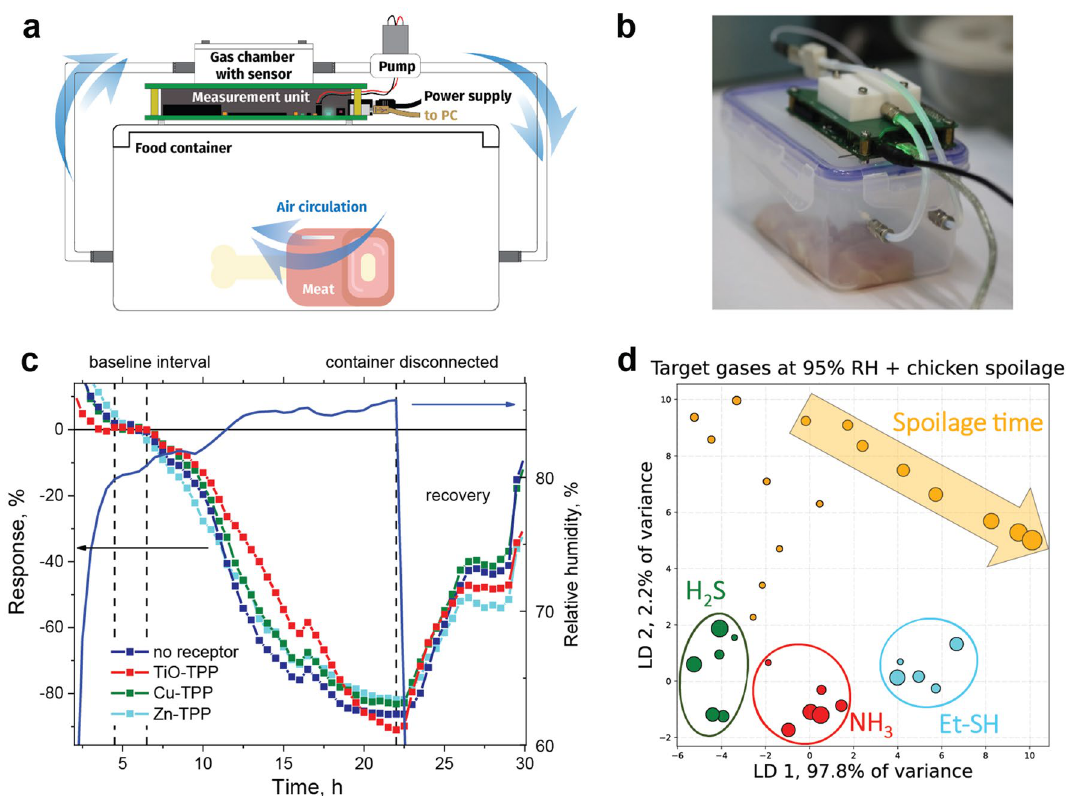
Figure 5. Food experiments. ( a ) Scheme of the meat spoilage experiment. ( b ) Setup photo with a piece of chicken breast, the electronic nose and a membrane micropump mounted on the top. ( c ) Response-time dependence over spoiling meat for the sensor groups with different receptor layers, relative humidity measured with a reference sensor is plotted in blue line and linked to the right axis. ( d ) LDA diagram of the signal growth during meat decomposition with response measurements of the target analytes considered as a training dataset and the data recorded during meat spoilage as a test dataset, each dot corresponds to 1 h interval and dot size with the arrow—to its growth